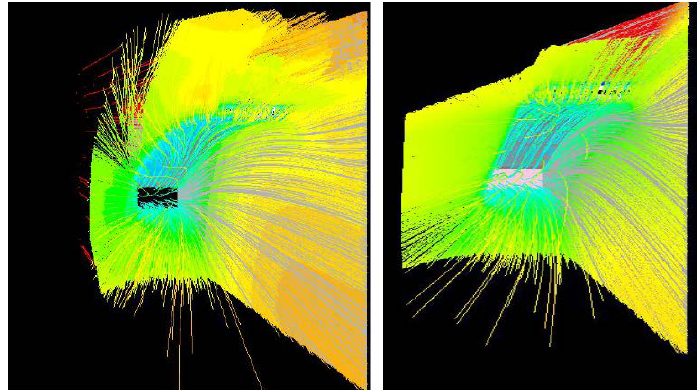
Figure 25. Mach streamlines for SERN DP456 with small ( left ) and large ( right ) side fence.